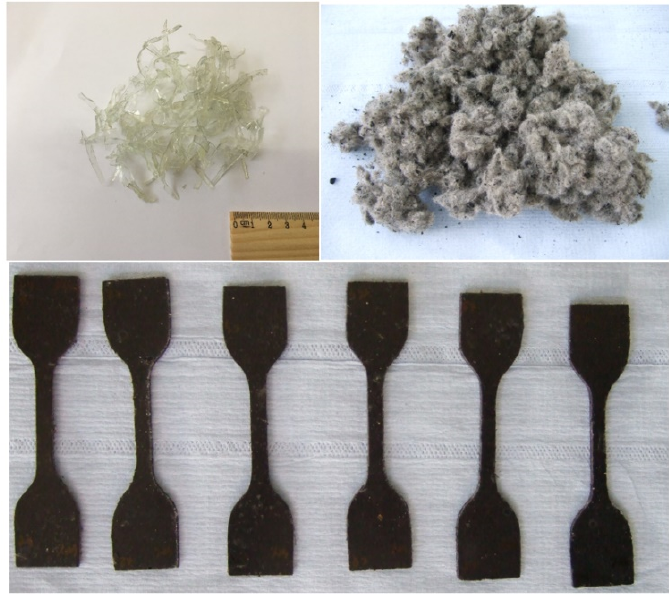
Figure 2. The main components for composites [authors’ own processing].